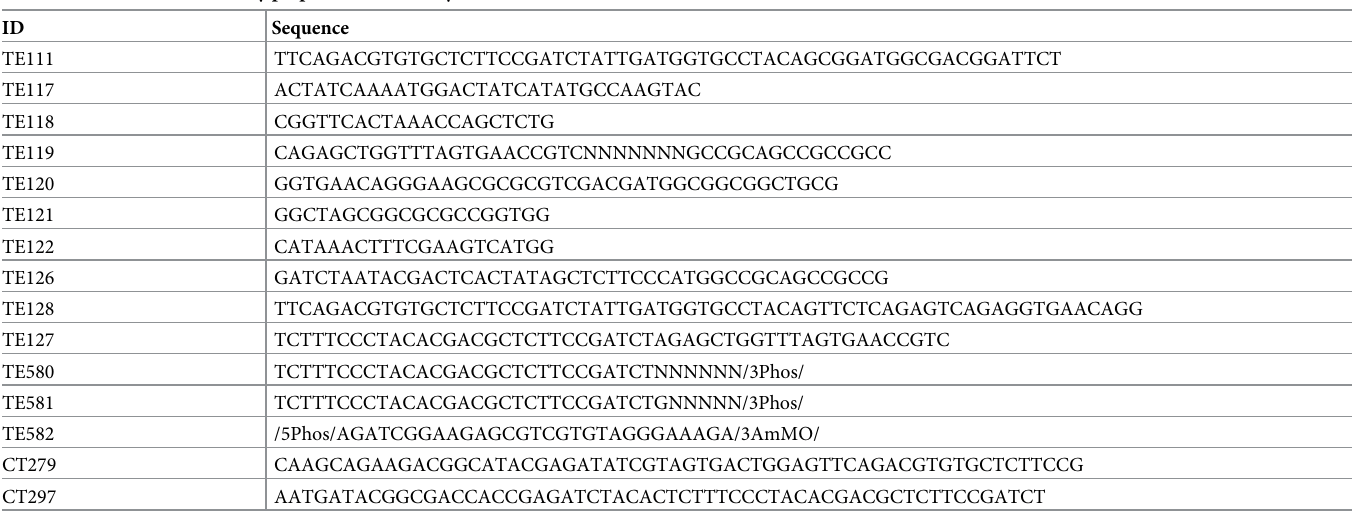
Table 1. Primers used in library preparation and